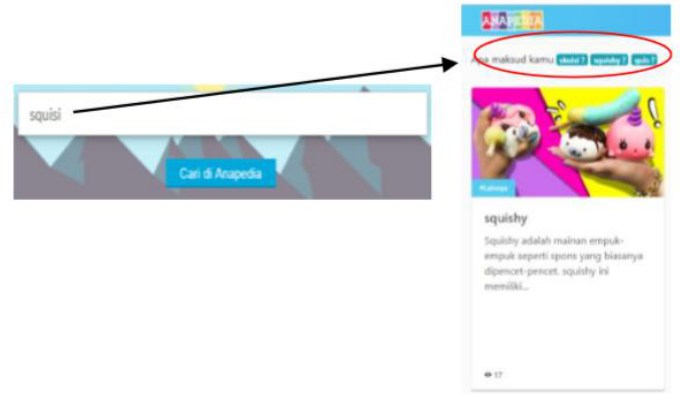
Fig. 6 Spelling checker automatically for searching